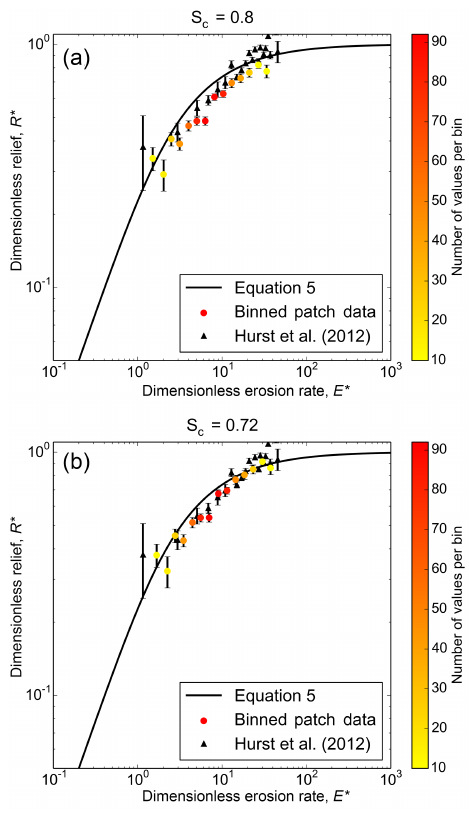
Figure 5. Binned hilltop patch data spanning a wide range of E ∗ values generated using a critical gradient of 0.8 (a) and 0.72 (b) alongside data from Hurst et al. (2012) for the same location. Error bars are the standard error of the data. Error bars from Hurst et al. (2012) are generated from the original